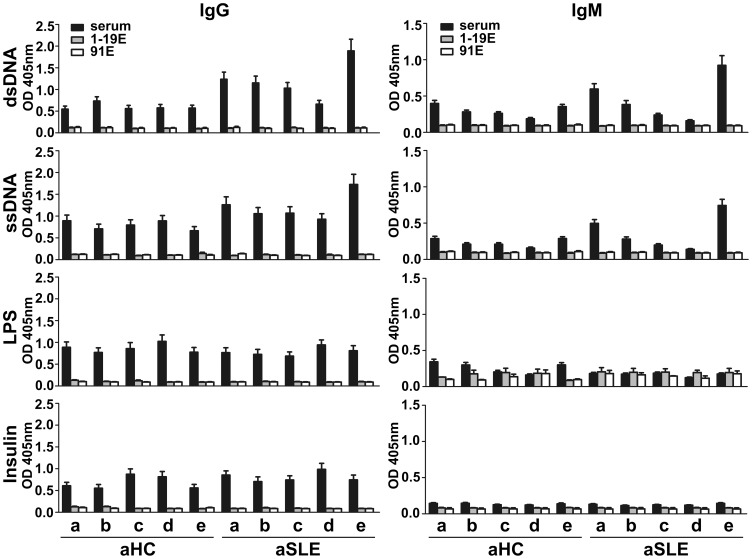
Polyreactivity test by ELISA.dsDNA, ssDNA, LPS or insulin was coated on microtiter plates as described in Materials and Methods. Sera (1∶100 dilution) and Abs purified from the H31–19 or H31–19K9me beads (1∶200 dilution) were tested. KT47 anti-human IgG or KT16 anti-human IgM Ab was used as the primary Ab and HRP-conjugated goat anti-mouse IgG was used as the secondary Ab. a, IgG(1–19low91low)IgM(1–19high91high); b, IgG(1–19low91low)IgM(1–19high91low); c, IgG(1–19low91low)IgM(1–19low91high); d, IgG(1–19low91low)IgM(1–19low91low); e, IgG(1–19high91x)IgM(1–19x91x). 1–19E, Abs eluted from the H31–19 beads; 91E, Abs eluted from the H31–19K9me beads. Data are expressed as mean+SEM. The results are representative of two separate experiments.